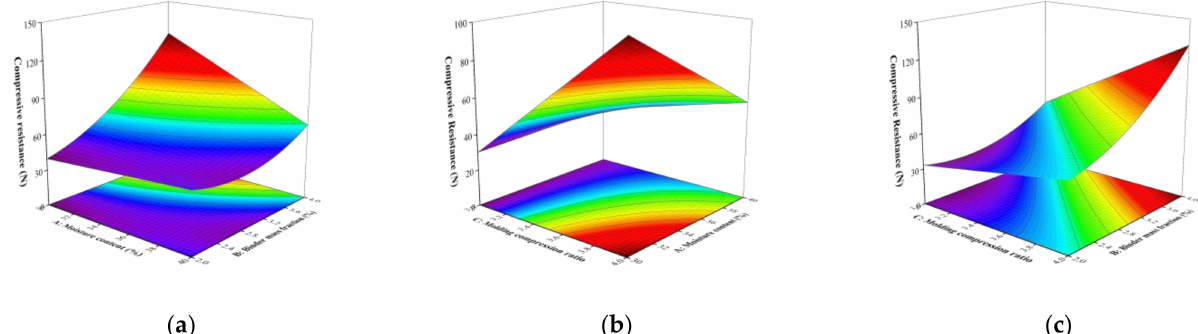
Figure 6. Interaction effect on compressive resistance. ( a ) Effect of moisture content and binder mass fraction on compressive resistance with the molding compression ratio of 3.5:1 and strain maintenance time of 60 s; ( b ) Effect of moisture content and molding compression ratio on compressive resistance with the binder mass fraction of 3% and strain maintenance time of 60 s; ( c ) Effect of binder mass fraction and molding compression ratio on compressive resistance with the moisture content of 35% and strain maintenance time of 60